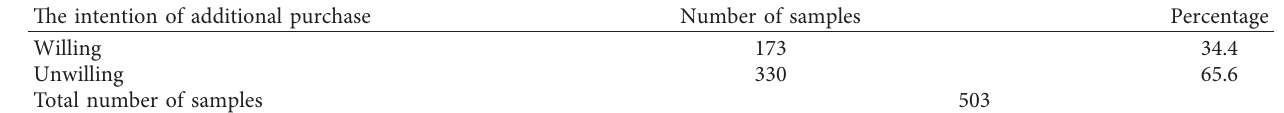
Table 4: Analysis of additional purchases in the questionnaire scenario.